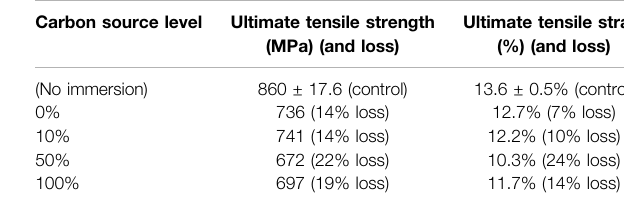
TABLE 6 | Ultimate tensile strength and ultimate tensile strain data from Figure 13